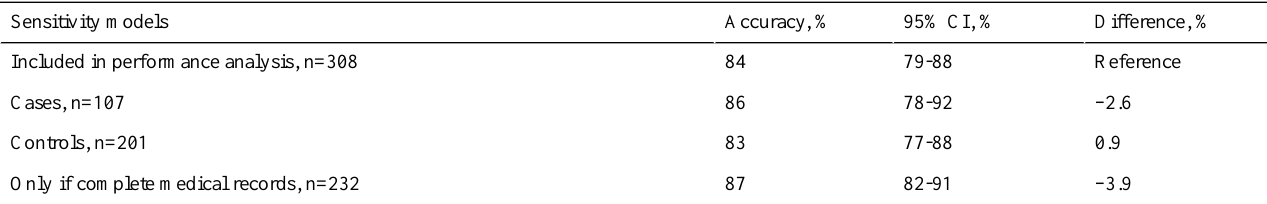
Table 6. Sensitivity analyses: differences in overall